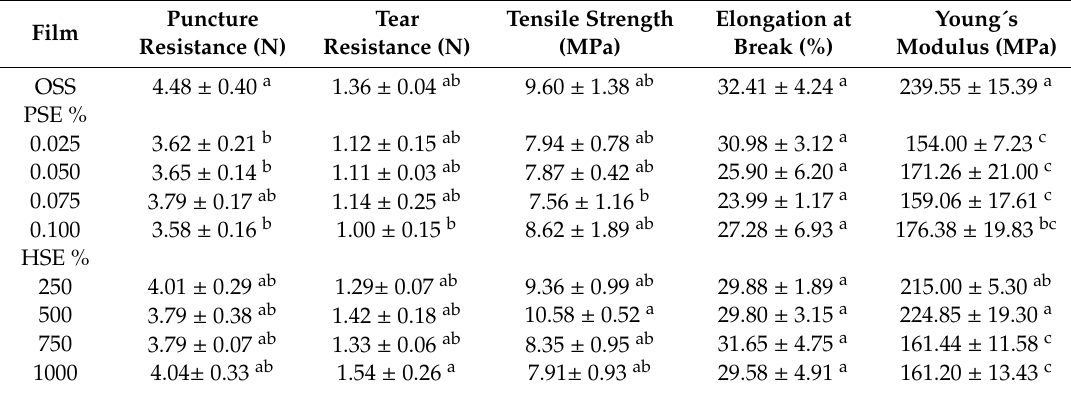
Table 6. Mechanical properties of octenyl succinate starch